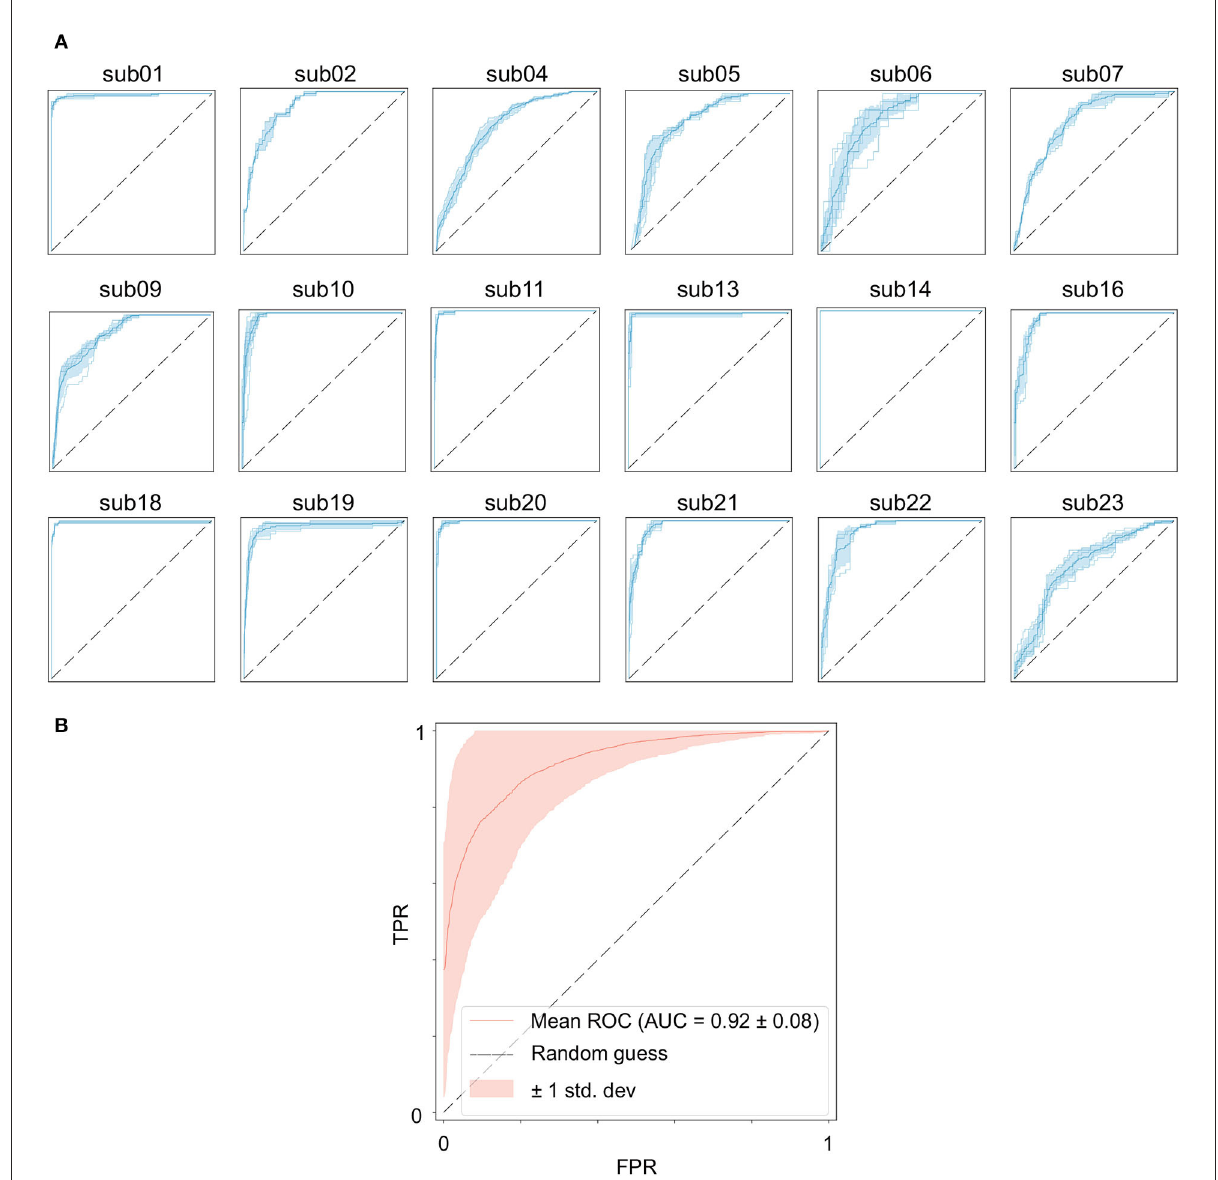
FIGURE4 Performance of the GCN model for seizure prediction. (A) ROC curves of each subject, (B) ROC curves of all